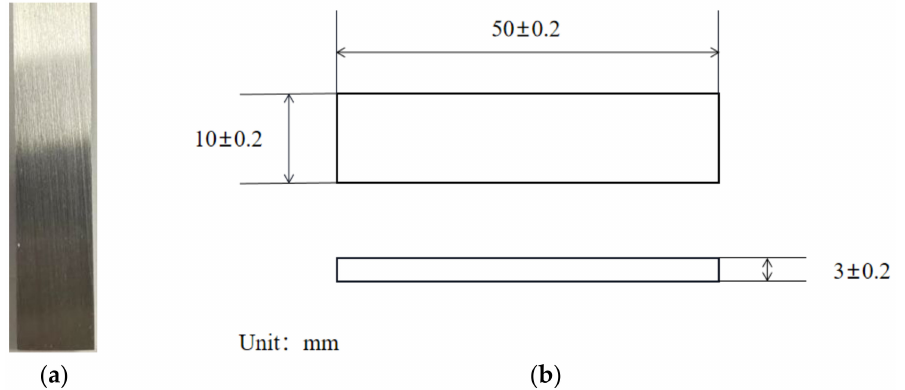
Figure 1. ( a ) Specimen after polishing; ( b ) the size of 80S steel.